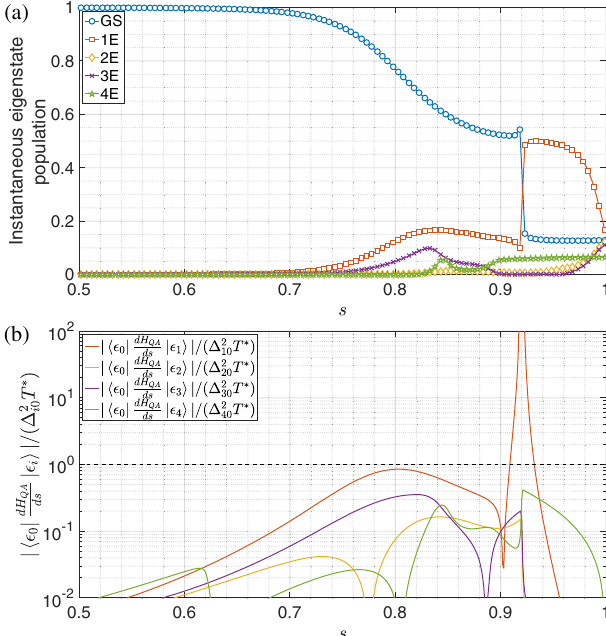
FIG. 13. (a) Instantaneous eigenstate populations along the linear-ramp quantum annealing path given by Eq. (9) for the example graph in Fig. 6(b). The annealing time is chosen to be T ¼ T (cid:3) ¼ 40 , which corresponds to the time where the diabatic bump occurs in Fig. 6(c). (b) Coupling between the instantaneous ground states and the first few excited states. The plotted quantities measure the degree of adiabaticity [as explained in Eq.